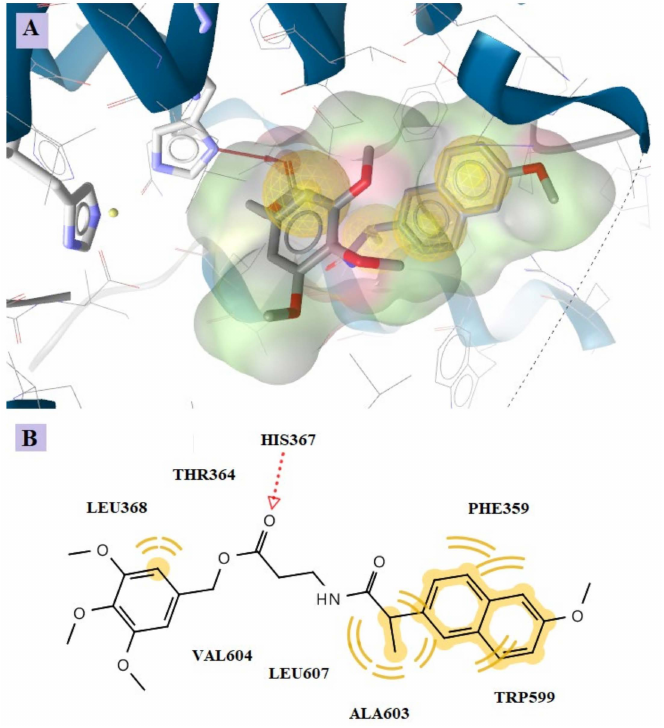
Figure 6. ( A ) Docking pose of most active compound 17 in 5-LOX enzyme. ( B ) 2D interaction diagram of compound 17 with the key amino acids in 5-LOX. Active site zinc shown as yellow small sphere, red dotted arrows indicate H-bond, and yellow spheres hydrophobic